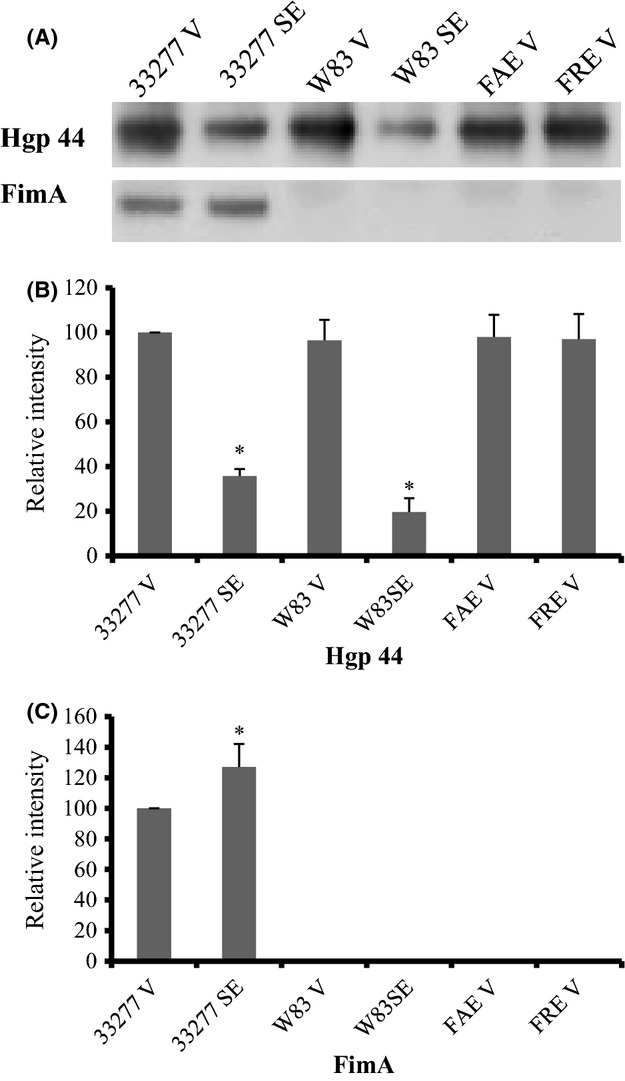
Expression of Hgp44 and FimA in Porphyromonas gingivalis vesicles. (A) Levels of FimA and Hgp44 of gingipains in surface extracts (SE) of P. gingivalis 33277 or an afimbriated strain (W83), and in vesicles (V) of 33277, W83, fimA mutant (FAE), and fimR mutant (FRE) were analyzed using western blot analysis with rabbit anti-FimA or rabbit anti-Hgp44 sera. (B, C) Semiquantitation of western blots was conducted with ImageJ software. Each bar represents the relative intensity of (B) Hgp44 and (C) FimA. Values are shown with their standard deviations (n = 3). An asterisk indicates a significant difference between the relative level of Hgp44 or FimA in vesicles or surface extracts of P. gingivalis strains compared to those seen in 33277 vesicles (*P < 0.05 by t-test).